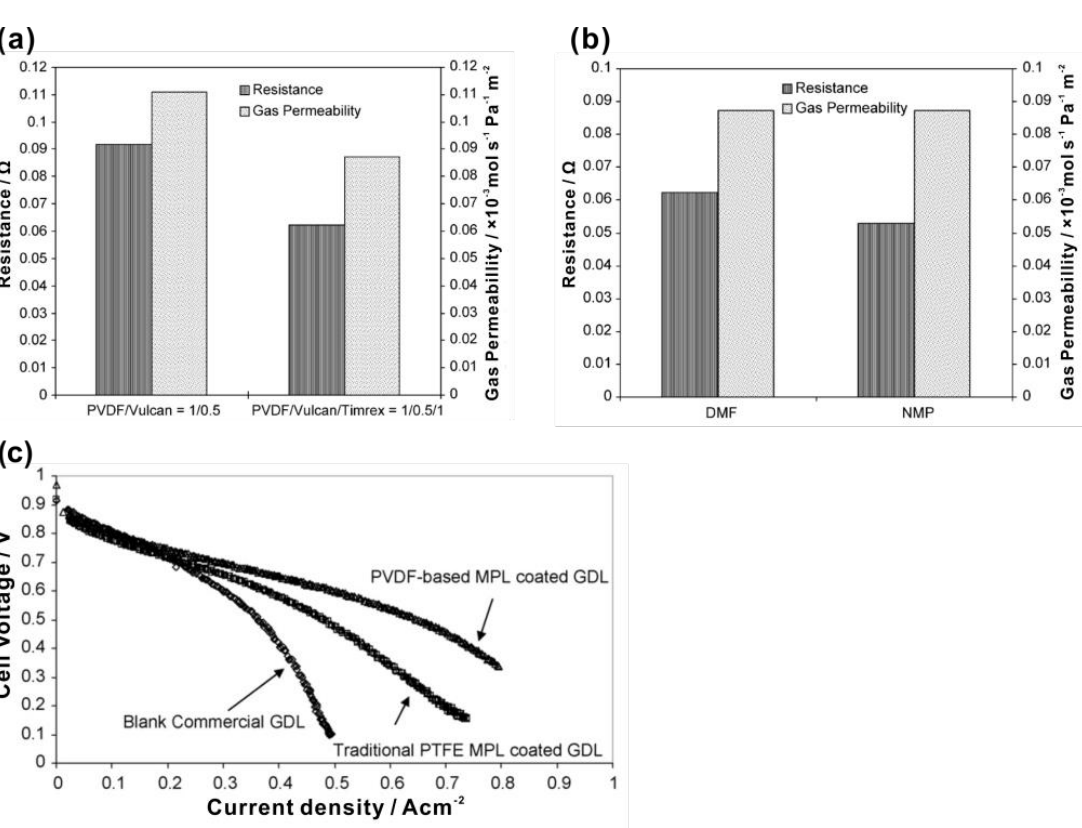
Figure 6. The resistance and gas permeability of ( a ) the MPL with PVDF-carbon black (Vulcan) added with and without electrically conductive filler (Timrex), and ( b ) the MPL using the PVDF solvent of DMF and NMP. ( c ) I–V curves of blank commercial GDL, traditional PTFE MPL-coated GDL and PVDF-based MPL-coated GDL. Reproduced with permission [72]. Copyright 2008, Else- vier.